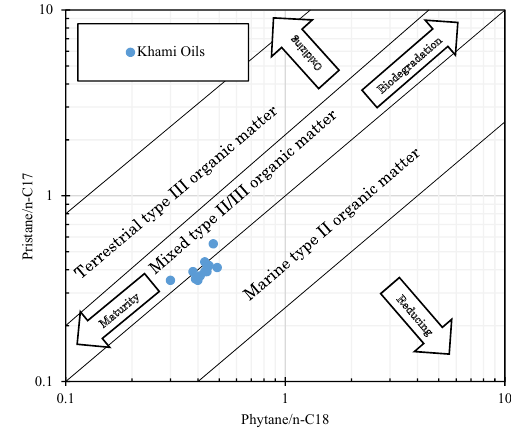
Fig. 6 Pristane/ n -C n -C 17 versus Phytane/ 18 for the South Dezful Embayment oils (after Peters et al. 1999)